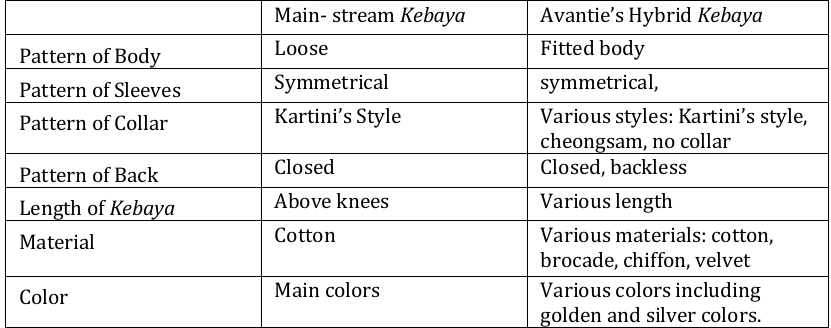
Table 1. Comparison between Main- stream kebaya and Avantie’s Hybrid Kebaya Main- stream Kebaya Avantie’s Hybrid Kebaya Pattern of Body Loose Fitted body Pattern of Sleeves Symmetrical symmetrical, Pattern of Collar Kartini’s Style Various styles: Kartini’s